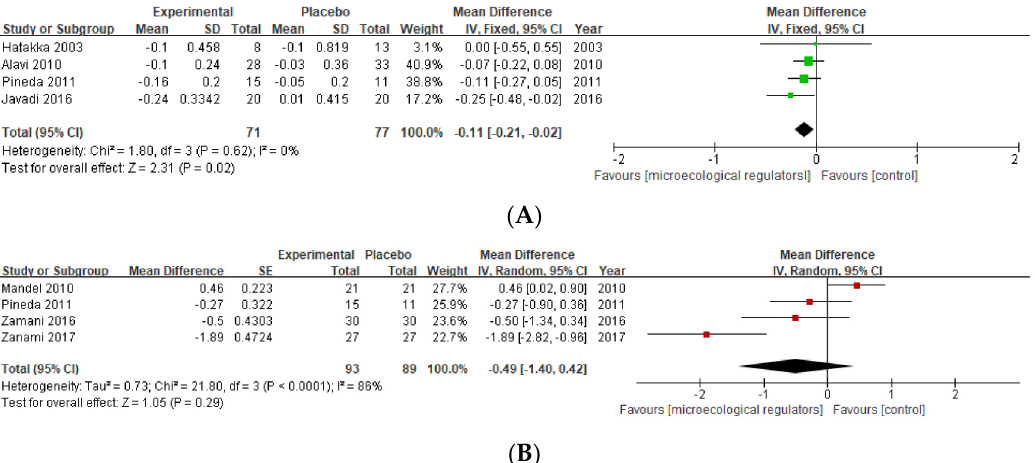
Figure 6. ( A ) Forest plot of HAQ variations in rheumatoid arthritis; ( B ) forest plot of pain—VAS variations in rheumatoid arthritis [37–42,45].